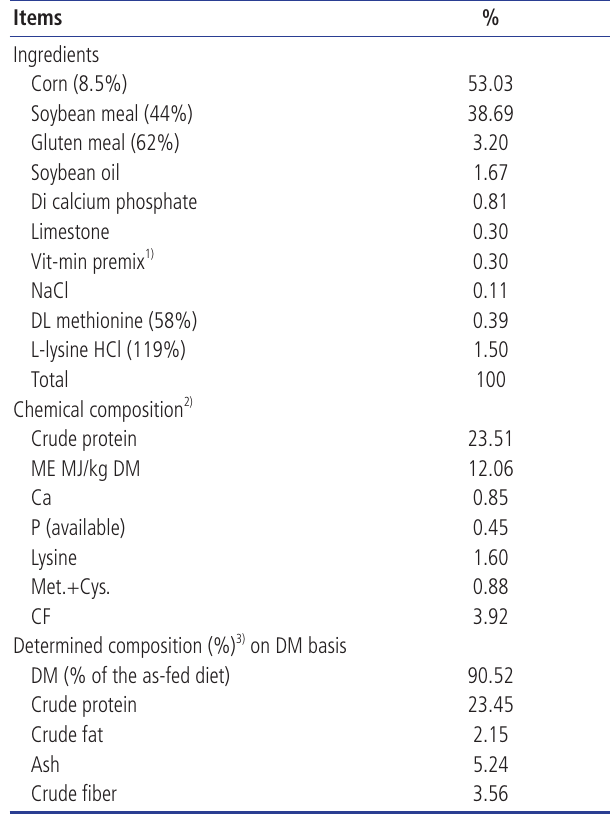
Table 1. Composition (as fed) and chemical analysis (on DM basis) of